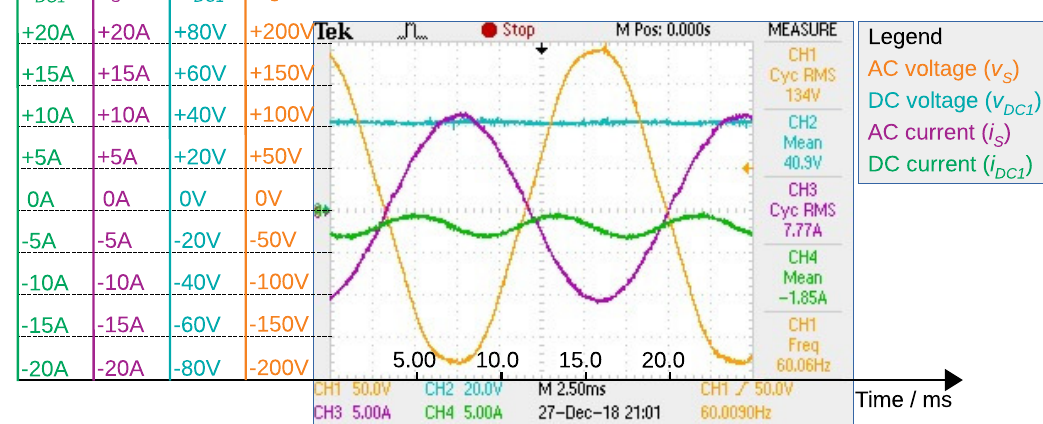
Figure 15. Measurements at 21:01 (of day 1)—Converter charging the batteries (stage I).